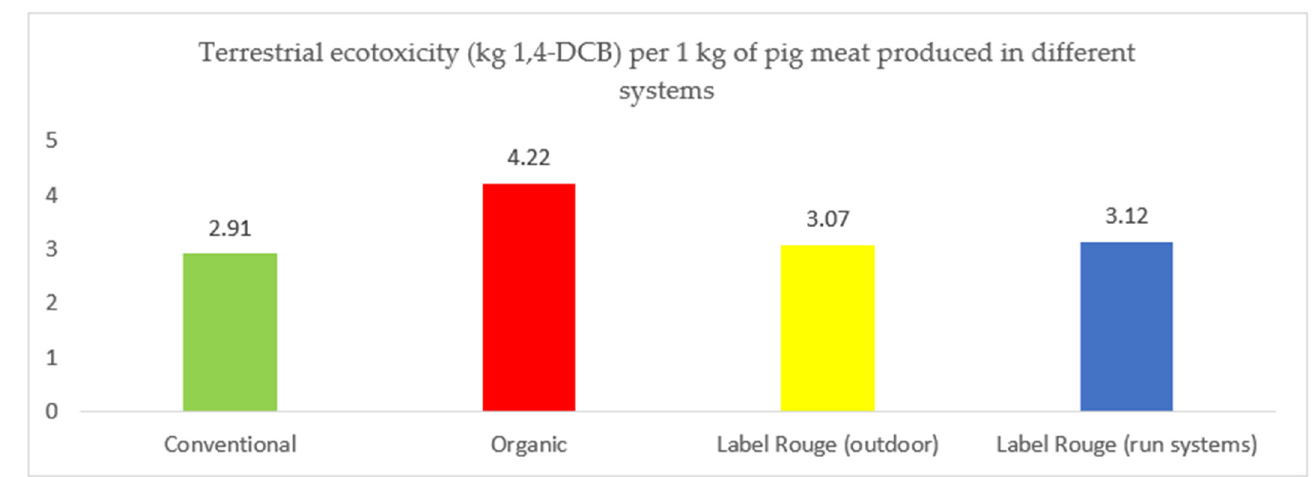
Figure 5. Land use required per 1 kg Pig meat across organic, Label Rouge and Conventional sys- tems: Data obtained from AGRIBALYSE ® database and computed using OpenLCA 1.10.2 [35,36].